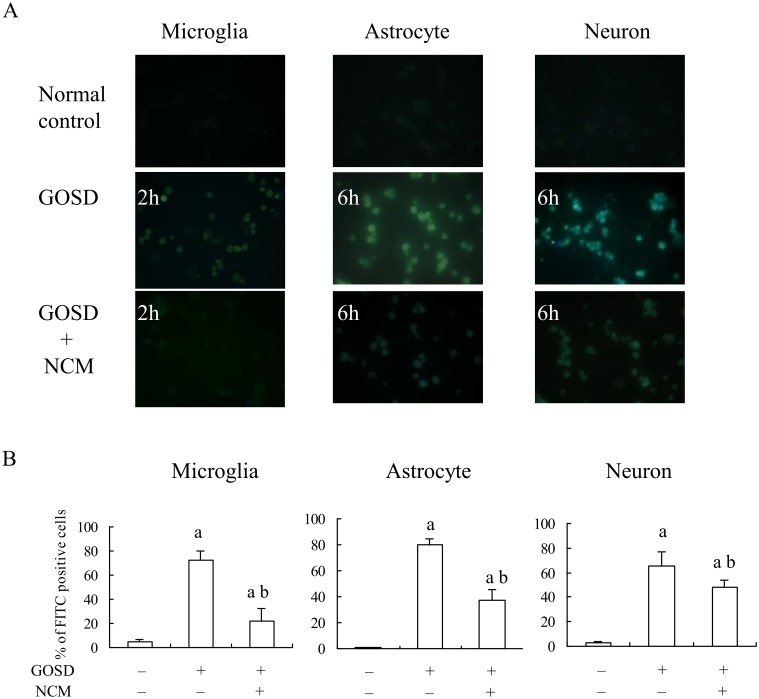
GOSD-induced apoptosis of brain cells was significantly inhibited by NCM.Microglia, astrocytes and neurons (4x105/well in 12-well plates) were cultivated under the GOSD condition for 2 h or 6 h, in the absence or presence of NCM. At the end of incubation, number of the apoptotic cells in each group was determined by TUNEL assay. The images of FITC-positive cells (apoptotic cells) were captured under the fluorescence microscope (A) and percent of FITC-positive cells (apoptotic cells) per visual field was further calculated and averaged from six randomly picked fields for each group (B). The magnification of images is 400X. aSignificant difference between lane 1 and the indicated lanes; bbetween lanes 2 and 3, p<0.05. Each experiment was repeated for 3 times. NCM was collected from neuronal culture under GOSD condition for 6 h.